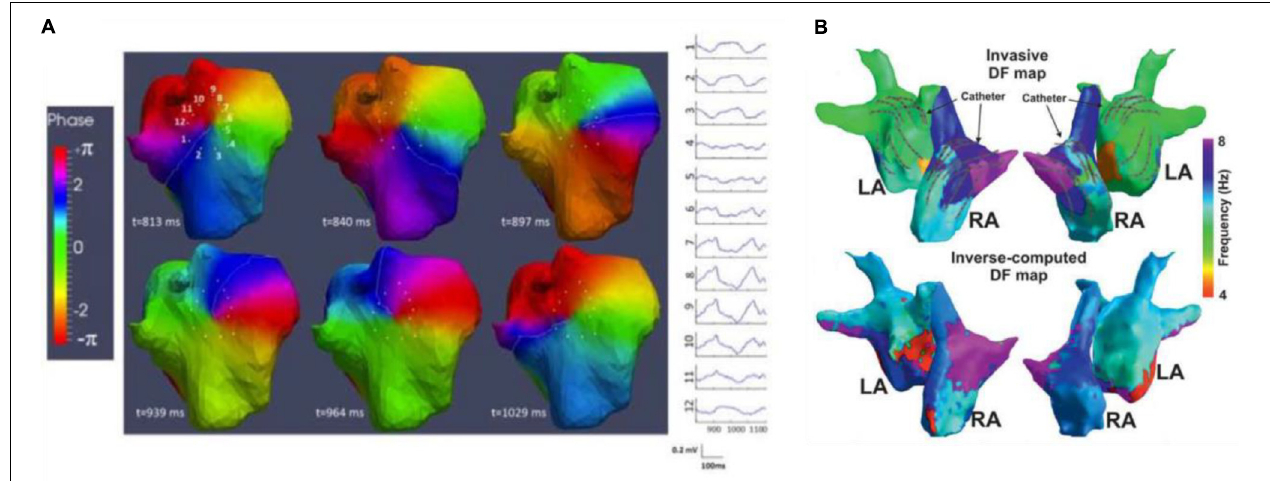
FIGURE 6 | During atrial (AF) or ventricular fibrillation, the mechanism of fibrillation can be assessed using phase and/or frequency mapping. (A) [adapted with permission from Haissaguerre et al. (2014)], ECGI derived phase maps of ≥ 1000-ms-long AF window show reentry events involving the posterior upper right atrium; sites 1–12 show the pre-phase electrograms around its core. By tracking phase singularities (PS) for reentrant activity of at least one full rotation, PS density maps illustrate arrhythmogenic drivers that may be targets for ablation. (B) [adapted with permission from Pedrón-Torrecilla et al. (2016)], dominant frequency (DF) using invasive CARTO (top) and non-invasive ECGI (bottom) in AF patients demonstrate good correspondence. Region of high DF (purple) identify arrhythmogenic drivers that may be targets for